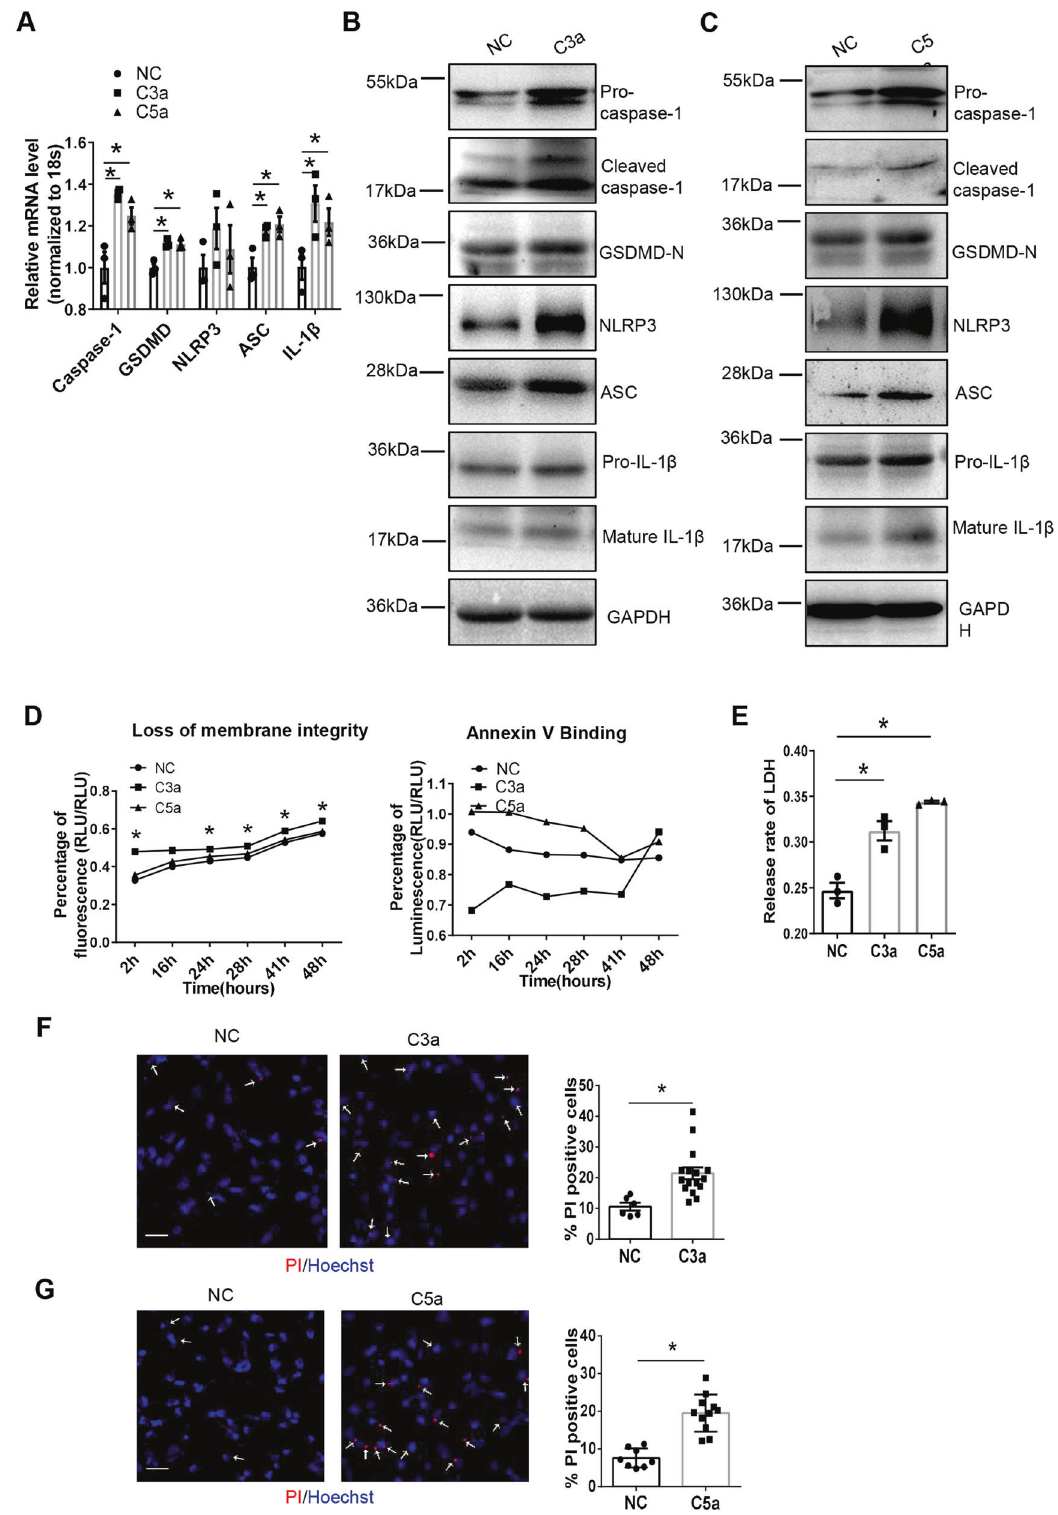
Fig. 2 Stimulation of complement triggers podocyte pyroptosis. Podocytes were treated with or without C3a (1 μ M) or C5a (100 nM). The pyroptotic features of podocytes, including GSDMD cleavage, membrane integrity, LDH release, and PI uptake, were assessed. A The expression of pyroptosis-related mRNAs was measured by qRT – PCR. B , C The levels of pyroptosis-related proteins were determined by western blotting. D The cell membrane integrity and apoptosis of podocytes were assessed using a microplate reader. E C3a and C5a promoted the release rate of LDH. F , G Microscopic imaging of podocytes stained with Hoechst 33342 and propidium iodide (PI) (scale bar = 50 μ m). The right panel represents the percentage of PI-positive podocytes (6 and 16 high-power fi elds were analyzed in group NC and group C3a respectively in ( F ); 8 and 11 high-power fi elds were analyzed in group NC and group C5a respectively in ( G )). The data in ( A ), ( D ), and ( E ) represent the mean ± SEM of three independent experiments. * p < 0.05. Cell Death and Disease (2022)